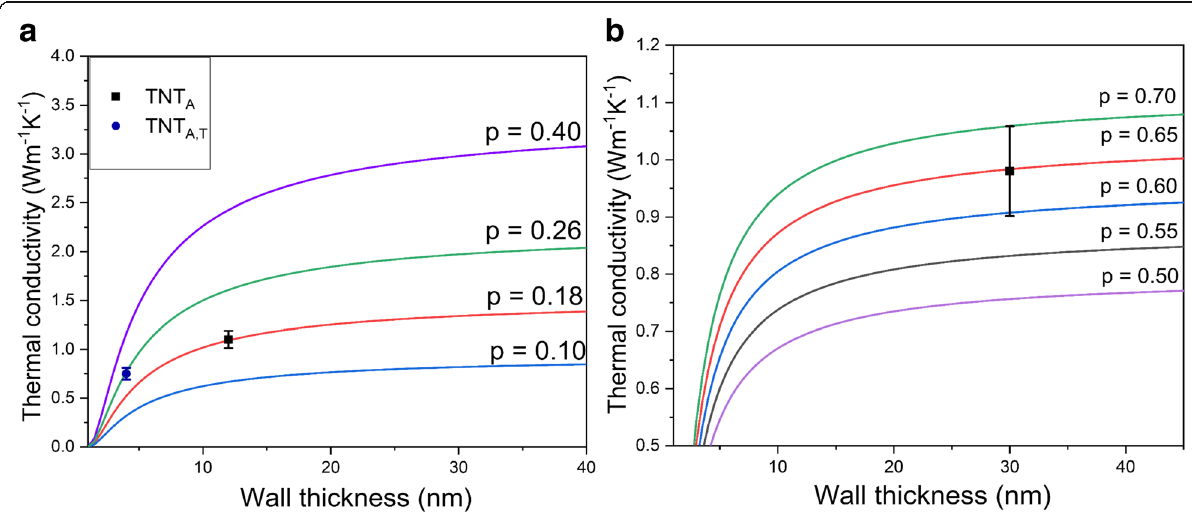
Fig. 6 Size-dependent thermal conductivity of a crystalline titania nanotubes (TNT A and TNT A,T ) and b amorphous nanotubes (TNT Amor ) with different surface roughness factors; symbols show the experimental thermal conductivity of the studied titania nanotubes and the solid lines indicate the calculated thermal conductivities by using Eq.